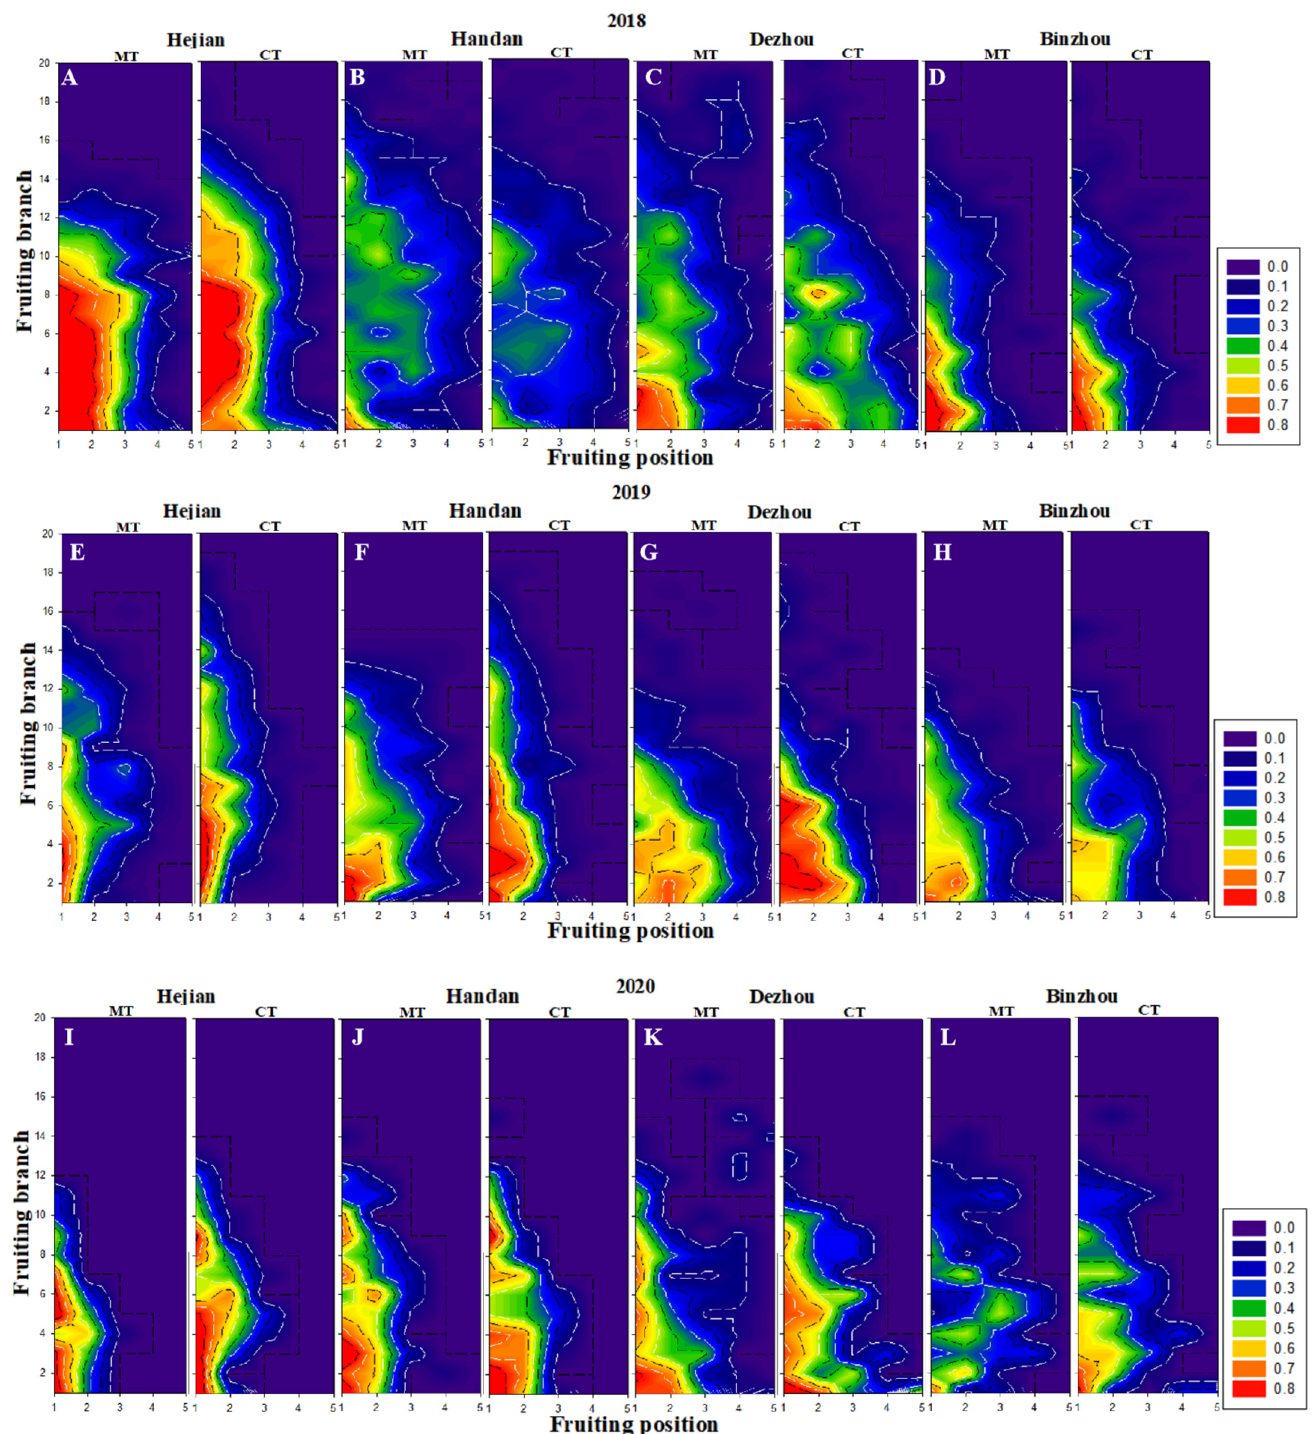
Figure 4. Effect of topping treatments during flowering on distribution of cotton bolls. MT and CT indicate manual topping and chemical topping, respectively. Hejian ( A , E , I ) and Handan ( B , F , J ) are in Hebei Province; Dezhou ( C , G , K ) and Binzhou ( D , H , L ) are in Shandong Province. Hebei Province; Dezhou ( C , G , K ) and Binzhou ( D , H , L ) are in Shandong